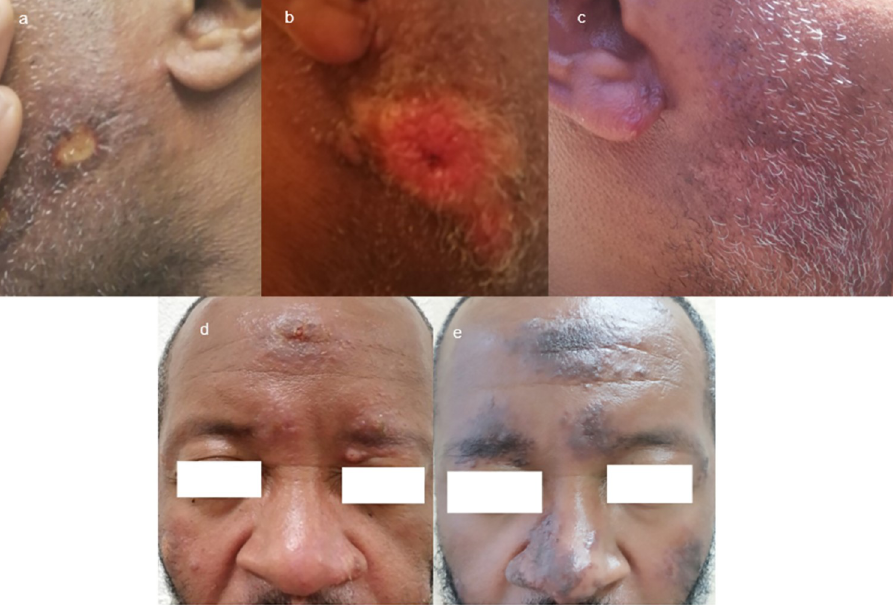
Fig 2. Clinical evolution of patient 1, CEFE outbreak, French Guiana, 2020: initial lesion of the left cheek ( 2a ), which improved after pentamidine; new lesion on the opposite cheek ( 2b ) improved after amphotericin B (2c ); new relapse occurred on the right ear and the forehead ( 2d ); after another unsuccessful amphotericin B course and three weeks of meglumine antimoniate (75mg/kg/d), improvement was seen on the face ( 2e ) but disseminated new lesions appeared. Healing was obtained after one month of oral miltefosine (50mg tid).